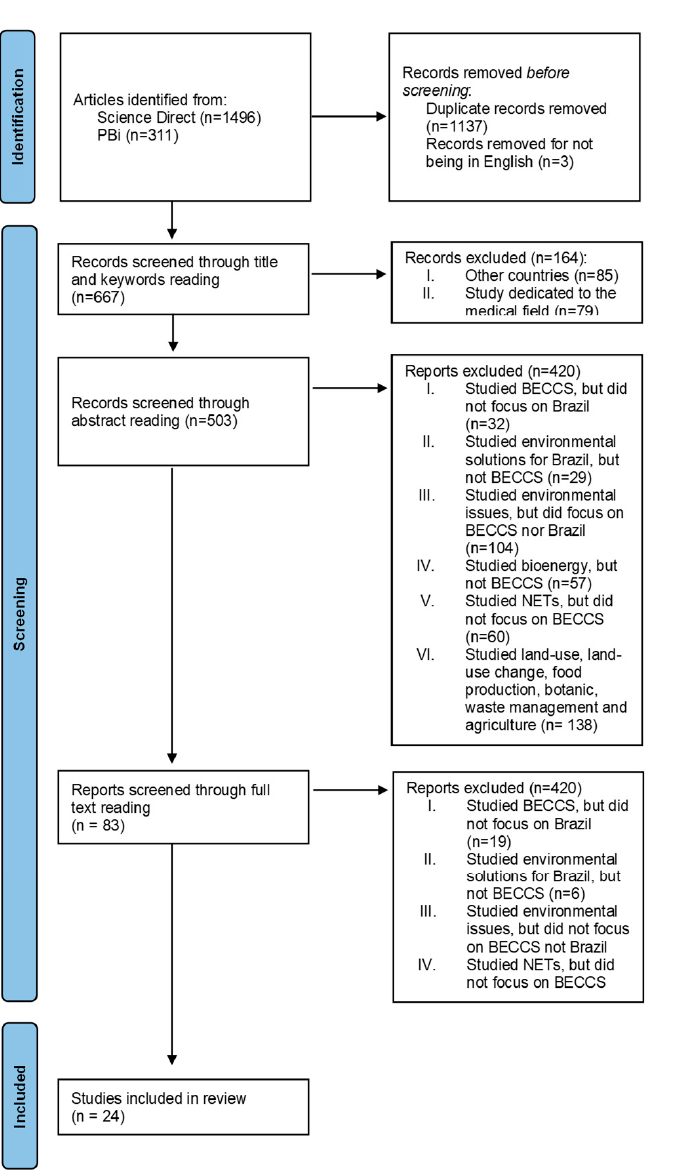
Figure 1. PRISMA flowchart for description of screening criteria and results. Source: author’s elaboration.